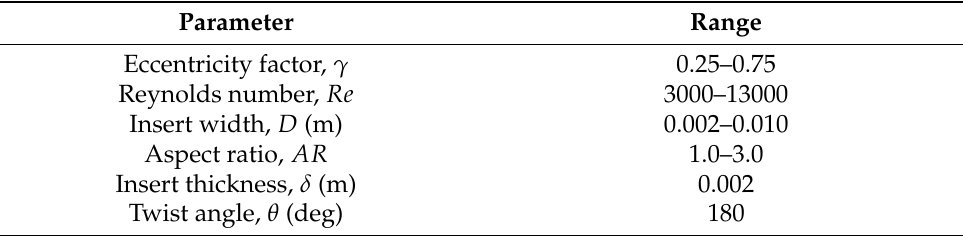
Table 1. Geometric Parameters of modified Kenics static mixer with an Eccentricity factor γ .